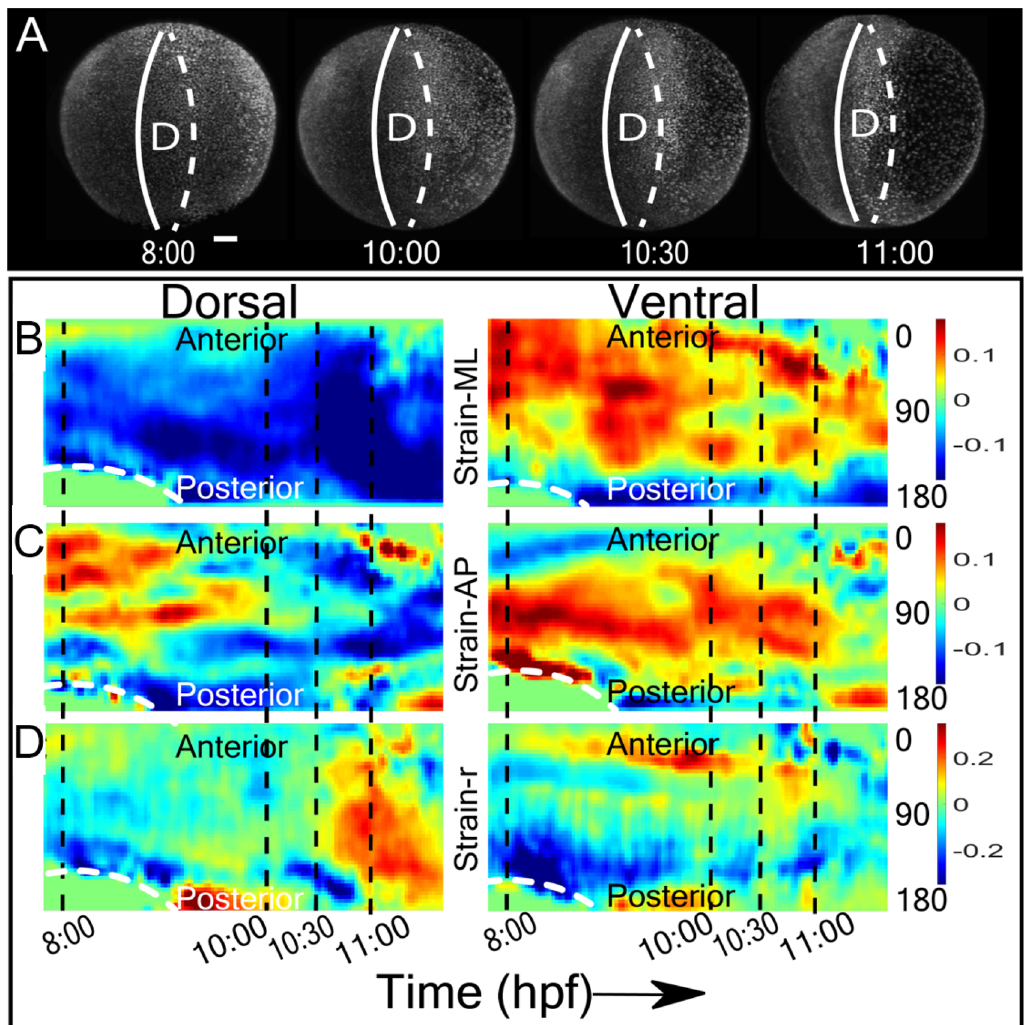
Figure 4. Time evolution of strain around the axial plane in the M-L, A-P and radial (‘r’) directions. ( A ) The dorsal view of the embryo at 8, 10, 10.5 and 11 hpf of zebrafish development. Strain is calculated along the embryo anterior–posterior axis corresponding to the dorsal (solid white band) and ventral (dashed white band) midline of the embryo. Scale bar—100 µm. ( B – D ) Kymograms of dorsal (left panels) and ventral (right panels) strain in the M-L ( B ), A-P ( C ), and radial, ‘r’ ( D ) directions and from 7.5 to 11.5 hpf (x-axis). The Y-axis measures strain around the anterior–posterior plane (white band in ( A ) of the embryo) from the anterior (0°) to the posterior side (180°). Dashed lines correspond to stages in ( A ). The white dotted line across the posterior side between 8 and 9 hpf indicates the margin of dorsal